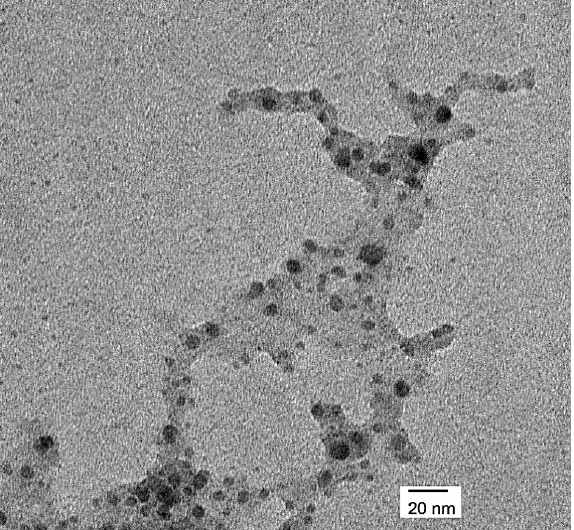
Figure 3. TEM micrographs of PEG encapsulated Fe 3 O 4 NPs in RNAse free water.